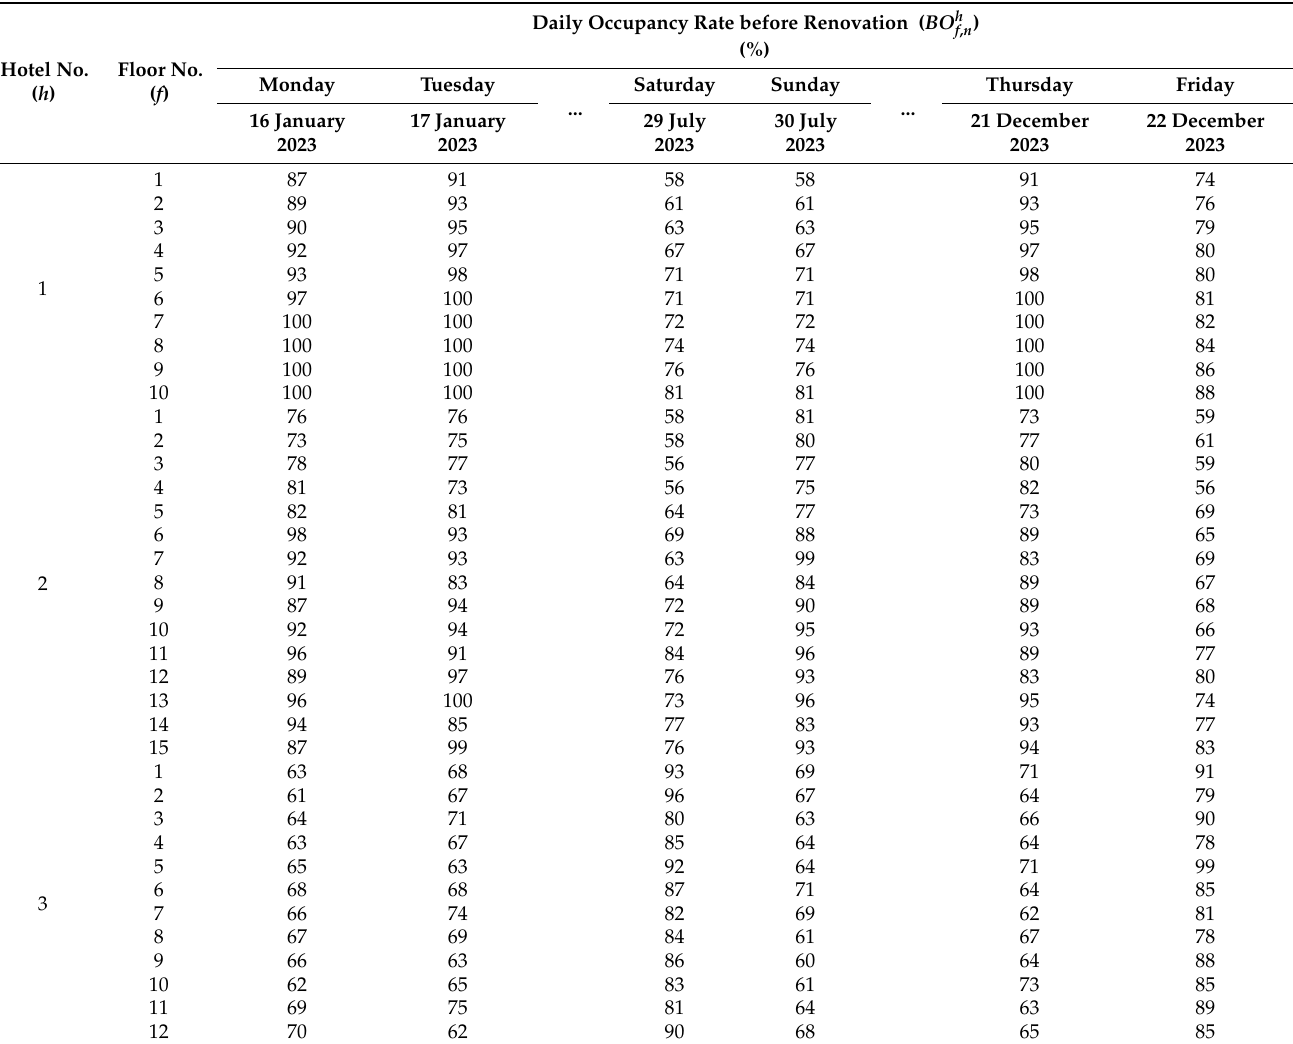
Table 4. Daily occupancy rates before renovation for sample days.